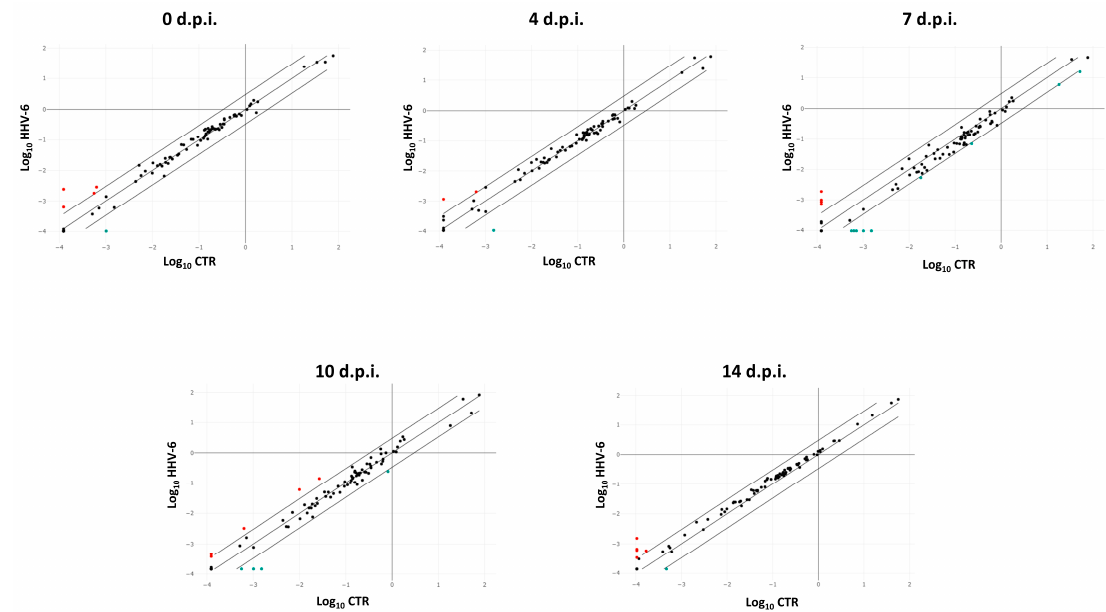
Figure 7. Scatterplot representation of the apoptosis-associated factors altered by human herpesvirus 6A (HHV-6A) infection in primary human dermal fibroblasts. At each time p.i. (d.p.i. = days post-infection), cell samples were collected and analyzed by specific qPCR microarray. The significance threshold was put at 3-fold expression change in infected vs. uninfected control cells. Red dots: upregulated factors; blue dots: downregulated factors; black dots: not significantly altered factors. Results represent mean values of duplicate samples from two independent experiments, and are expressed in logarithmic scale (Log 10 HHV-6 = logarithmic values in HHV-6A-infected cells; Log 10 CTR = logarithmic values in control uninfected cells).